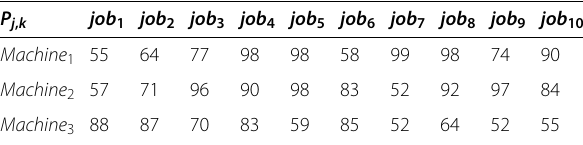
Table 2 Example of processing times for an instance of 10 jobs and 3